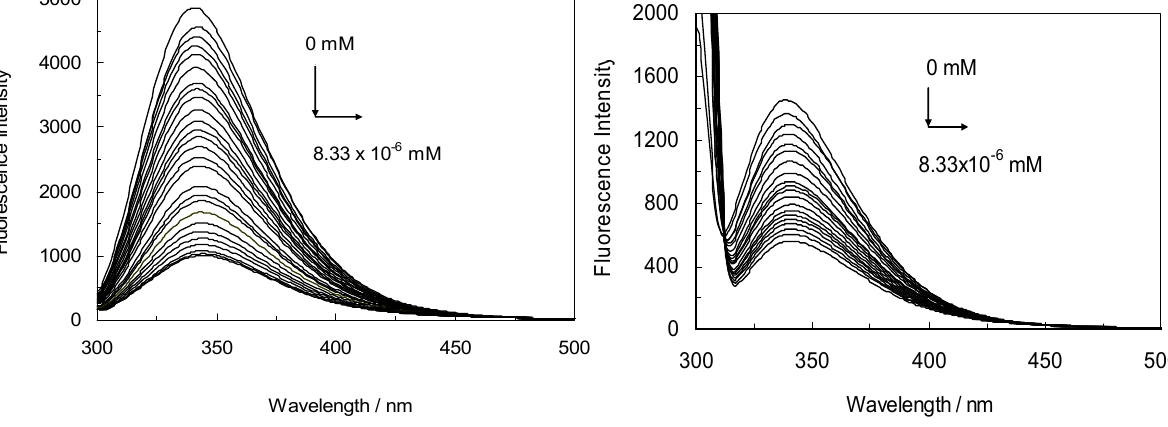
Figure 4. The fluorescence spectra of LYZ-CYC. Conditions: T = 298 K, pH = 7.4, = 280 nm. (right; λ = 295 nm), The concentration of LYZ was 1 × 10 − 3 mM and CYC λ ex ex was increased from 0 to 8.33 × 10 − 6 mM (for the sake of clarity, the red-shifts are shown with